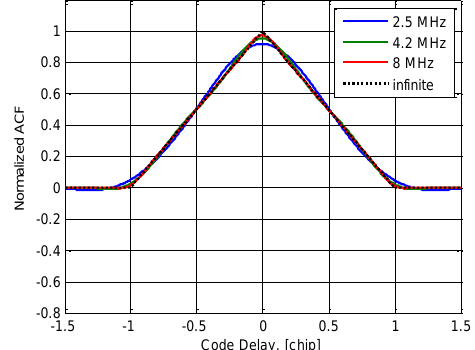
Figure 5. ACF of GPS L1 C/A signal for different RF front-end bandwidths.